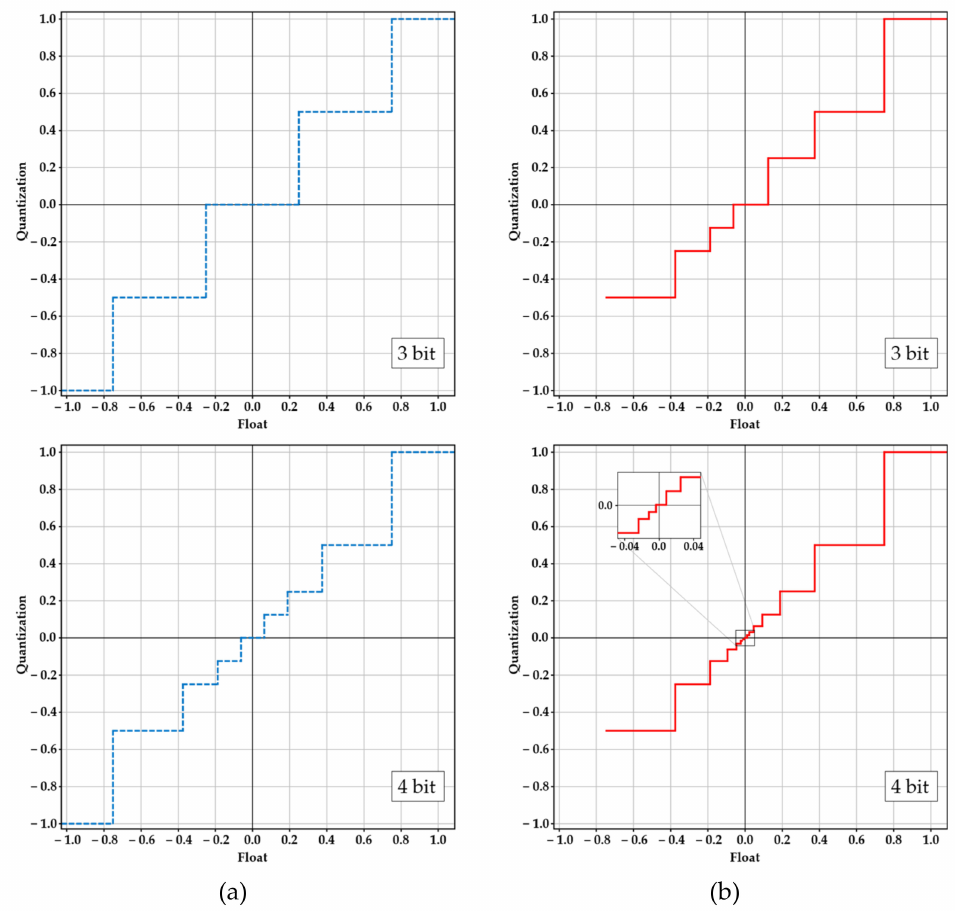
Figure 2. ( a ) The quantization strategies of INQ with different quantization bit-widths. ( b ) The quantization strategies of GSNQ with different quantization bit-widths. The horizontal axis of Figure 2 represents the full-precision floating-point